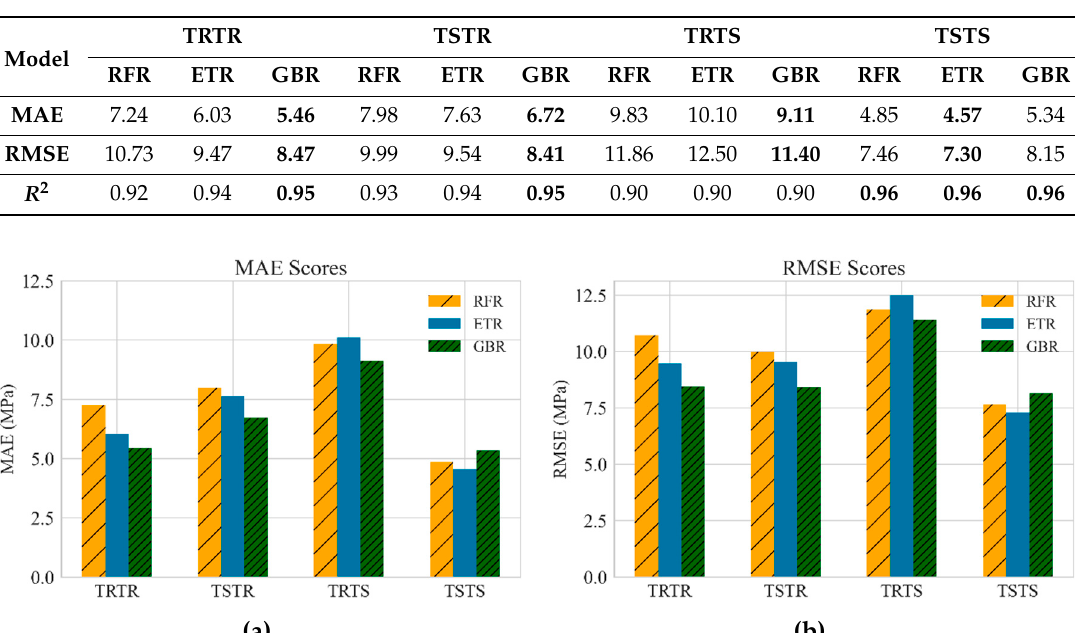
Table 5. Statistical performance indicators for developed models.